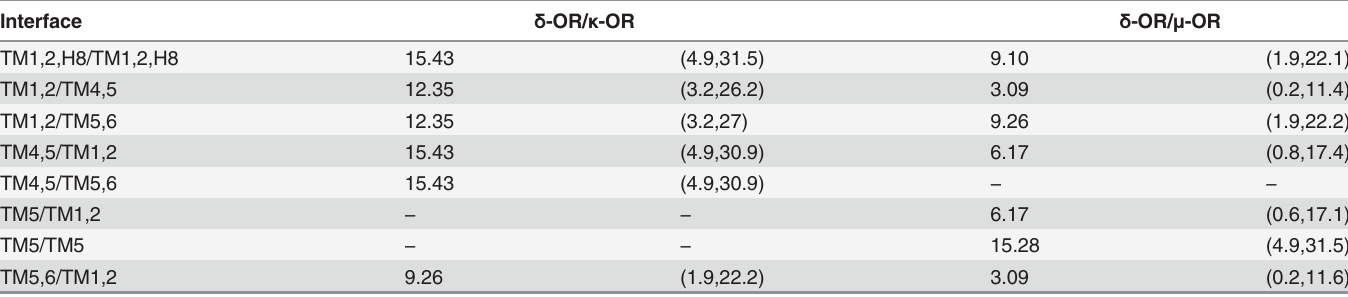
Table 4. Association rates of OR hetero-dimers formed during five independent MD simulations of the δ -OR/ μ -OR and δ -OR/ κ -OR systems. Interface δ -OR/ κ